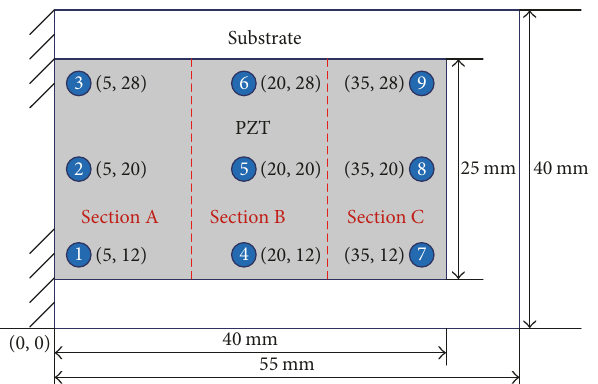
Figure 6: The nine virtual nodes in order to obtain stress in FEM